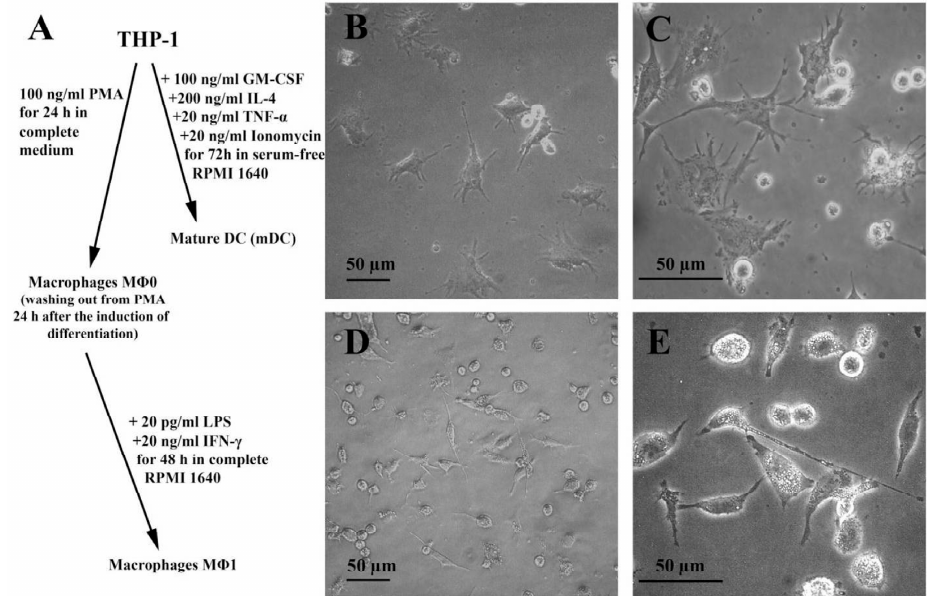
Figure 6. ( A ) Scheme of the differentiation protocol to obtain mature dendritic cells (mDCs) and pro-inflammatory macrophages (M Φ 1) from THP-1 cells; Light microscopy of mDCs ( B , C ) and M Φ 1 ( D , E ) cells under magnification of 200× and 400×, respectively.